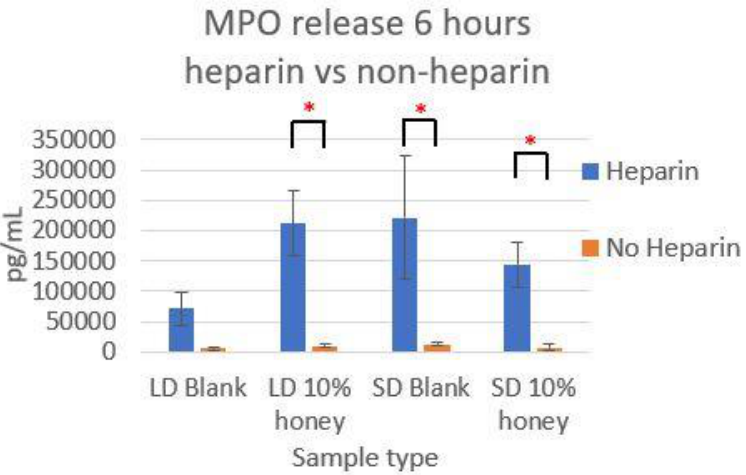
Figure 7. The release of non-NET-associated MPO is negligible. The concentration of MPO in the supernatant is shown for each sample cultured with or without the presence of heparin to free the MPO from the NETs. * indicates a significant difference between the indicated samples. Sample size of 3 replicates. Raw data is available in Supplementary Spreadsheet 5.